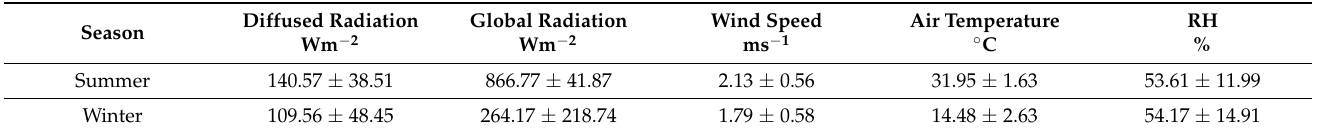
Table 2. Climatic values from the meteorological station from summer (22 July to 19 September 2021) and winter (6 December 2021 to 17 January 2022) growing seasons.